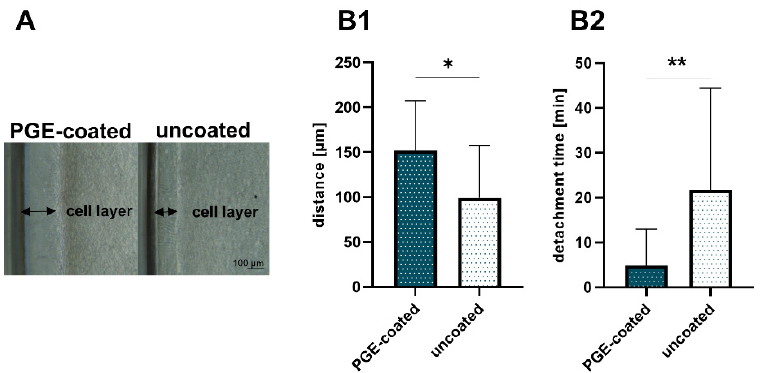
Figure 1. Self-detachment before thermal treatment and detachment time after treatment. ( A ) Cell- free border in poly(glycidyl ether) (PGE)-coated and uncoated control plates. ( B1 ) Distance between well wall and margin of the ligamentocyte layer measured in PGE-coated and uncoated plates, n = 3 independent experiments with ligamentocytes of different donors. ( B2 ) Detachment time in PGE-coated and uncoated plates, n = 4 independent experiments with ligamentocytes of four different donors. Scale bar: 100 µm ( A ). Statistic: One sample t-test, two-tailed (*). p values: * <0.05, ** <0.01 ( B1 , B2 ).